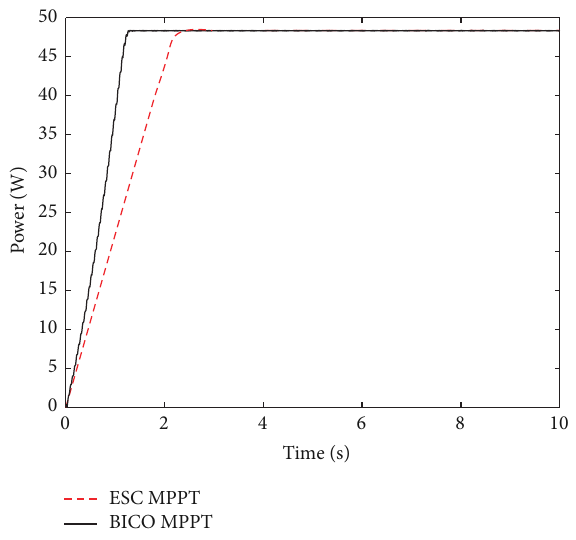
Figure 13: Performance of BICO MPPT and ESC MPPT in the presence of a white noise with noise power 0.04